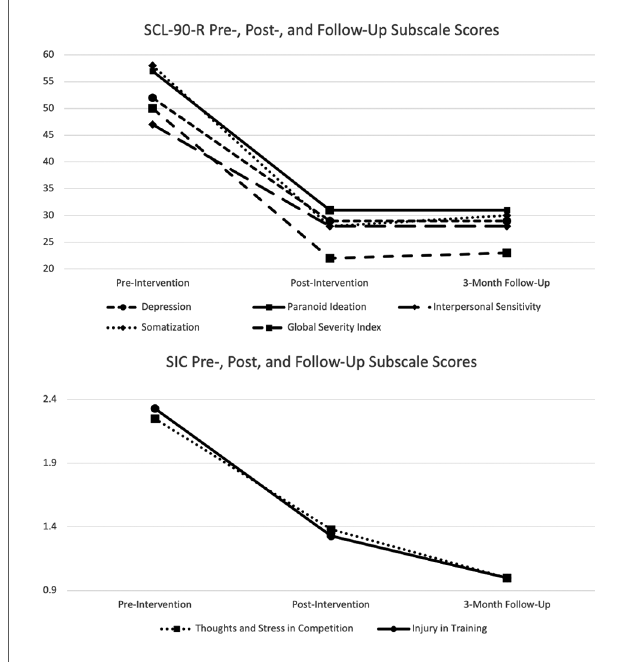
FIGURE 2 Pre-, post- and follow-up assessments of SCL-90-R and SIC